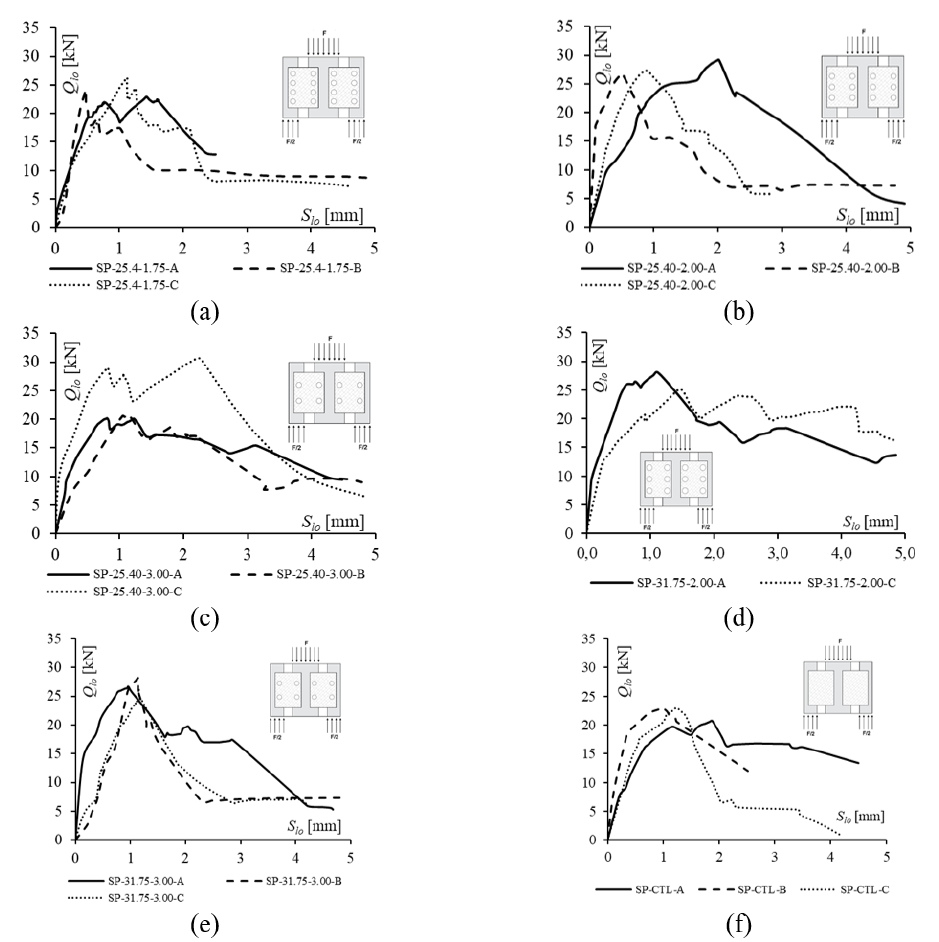
Figure 16. Load-relative displacement curves for: (a) SP-25.40-1.75; (b) SP-25.40-2.00; (c) SP-25.40-3.00; (d) SP-25.40-3.00 C;